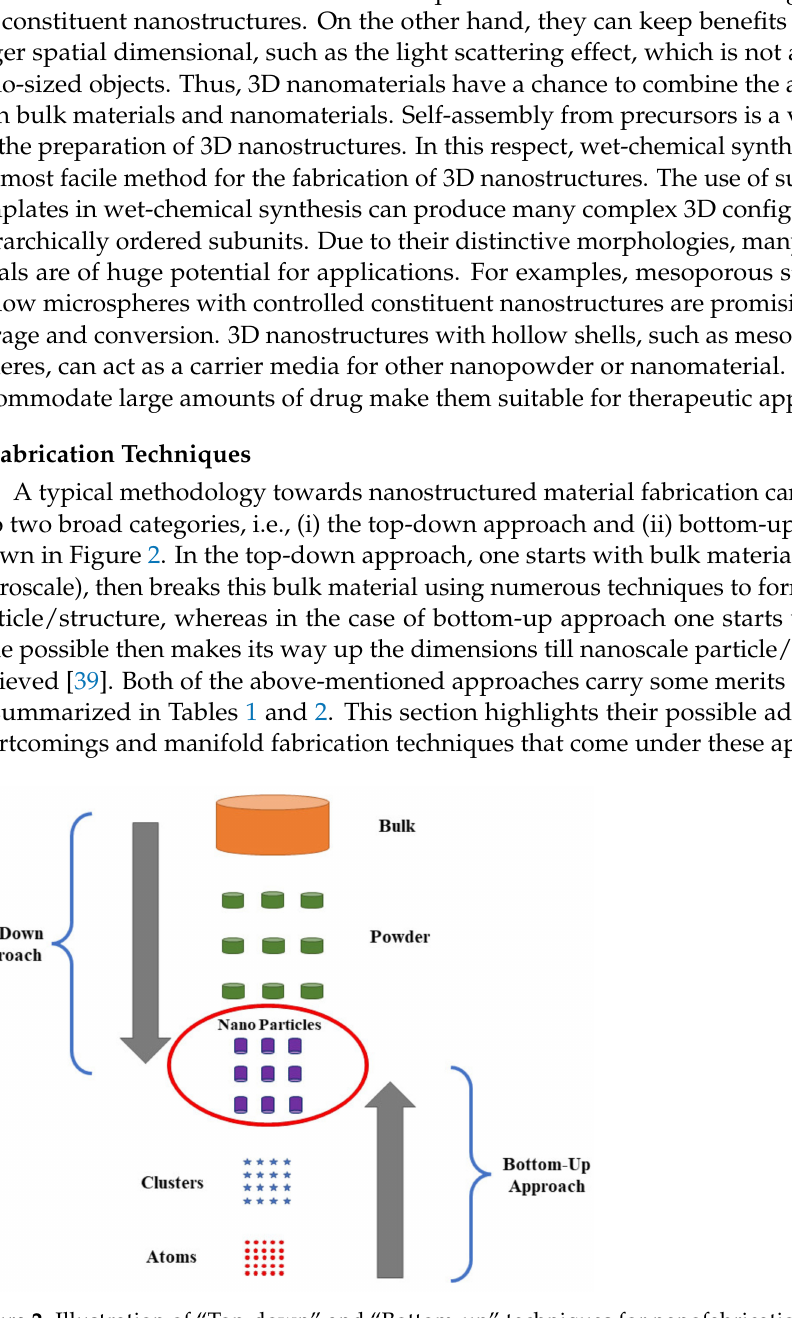
Figure 2. Illustration of “Top-down” and “Bottom-up” techniques for nanofabrication. Table 1. Advantages of “Top-down” and “Bottom-up” techniques for nanofabrication. Top-Down Approach Bottom-Up